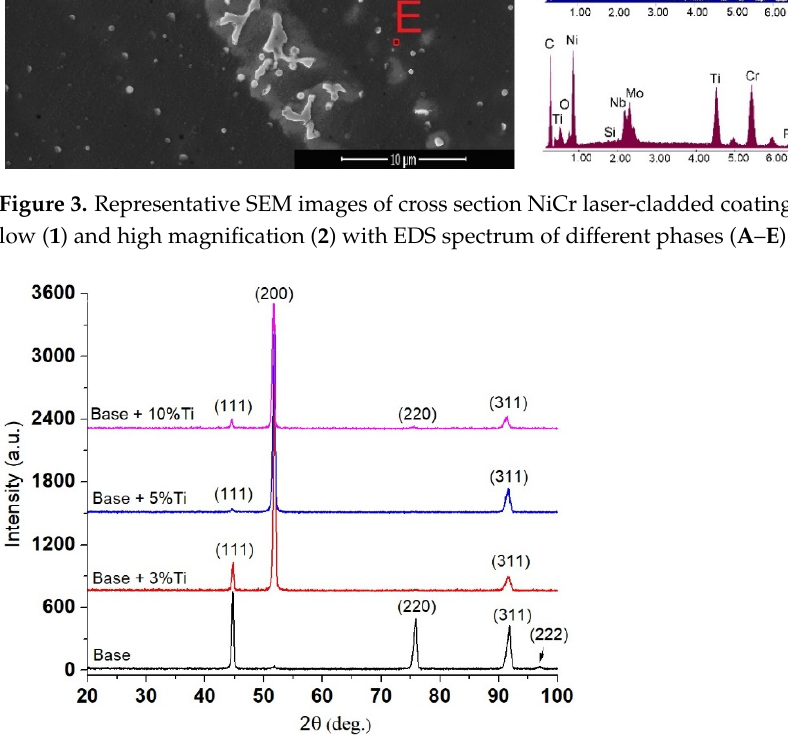
Figure 4. XRD spectrum of NiCr and NiCr(Ti) coatings with 3%, 5% and 10% Ti addition.